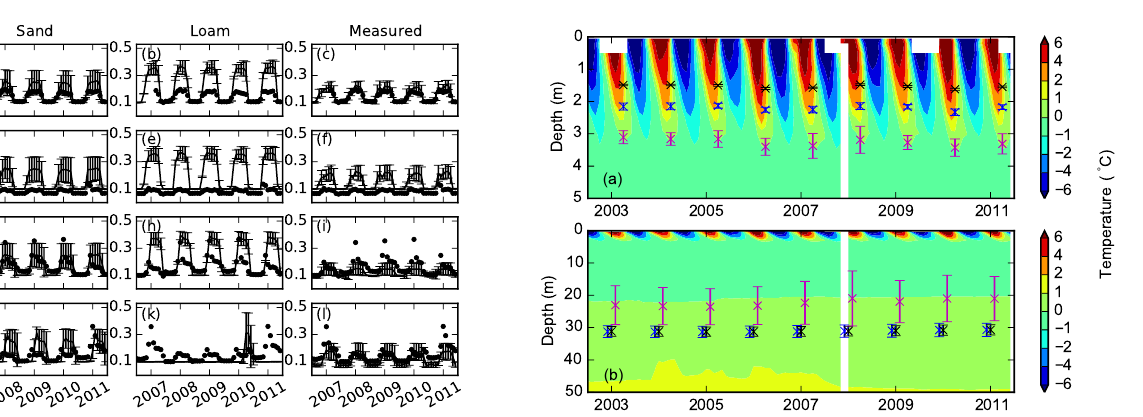
Figure 8. Contour plots showing (a) soil temperature ( ◦ C) from borehole measurements down to 5m superimposed with simulated active layer depths over the period of 2003–2011; and (b) ground temperature down to 50m superimposed with the simulated per- mafrost low boundary. Black, blue, and magenta represent simula- tions with loam, sand, and measured parameters. Error bars show the standard deviation calculated based on nine simulations with three different slopes and three different soil thicknesses (measured porosities were used in the simulation; white zones in the contour plots indicate missing borehole